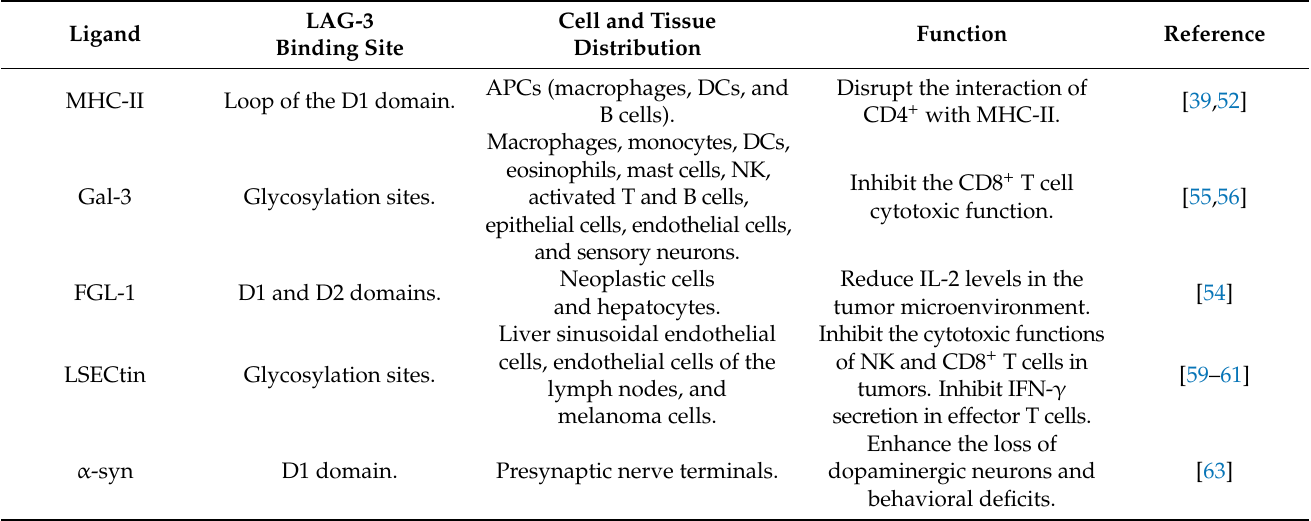
Table 1. LAG-3 binding ligands distribution and